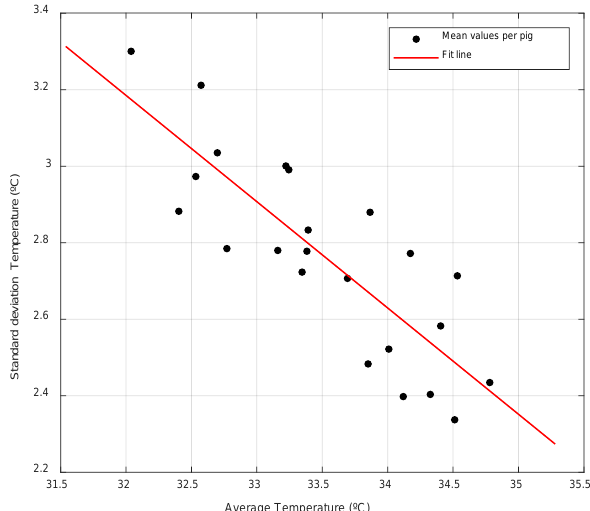
Figure 7. Ratio of the mean and standard deviation of the temperatures recorded during the test per animal (r 2 = 0.69; y = − 0.28x + 12).